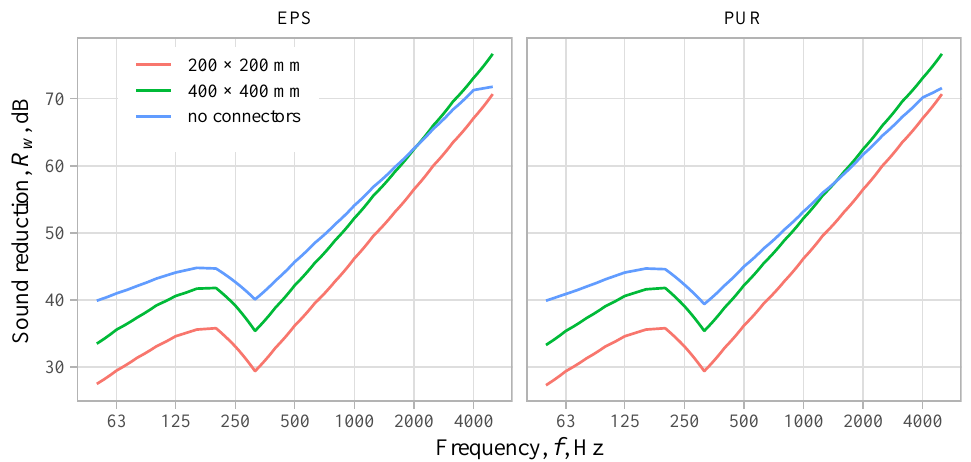
Figure 10. Sound reduction in the case of an SW with different arrangements of connectors (spacings of 200 × 200 mm, 400 × 400 mm and no connectors) and different wall compositions: with EPS (thickness 200 mm) and PUR (thickness 120 mm).